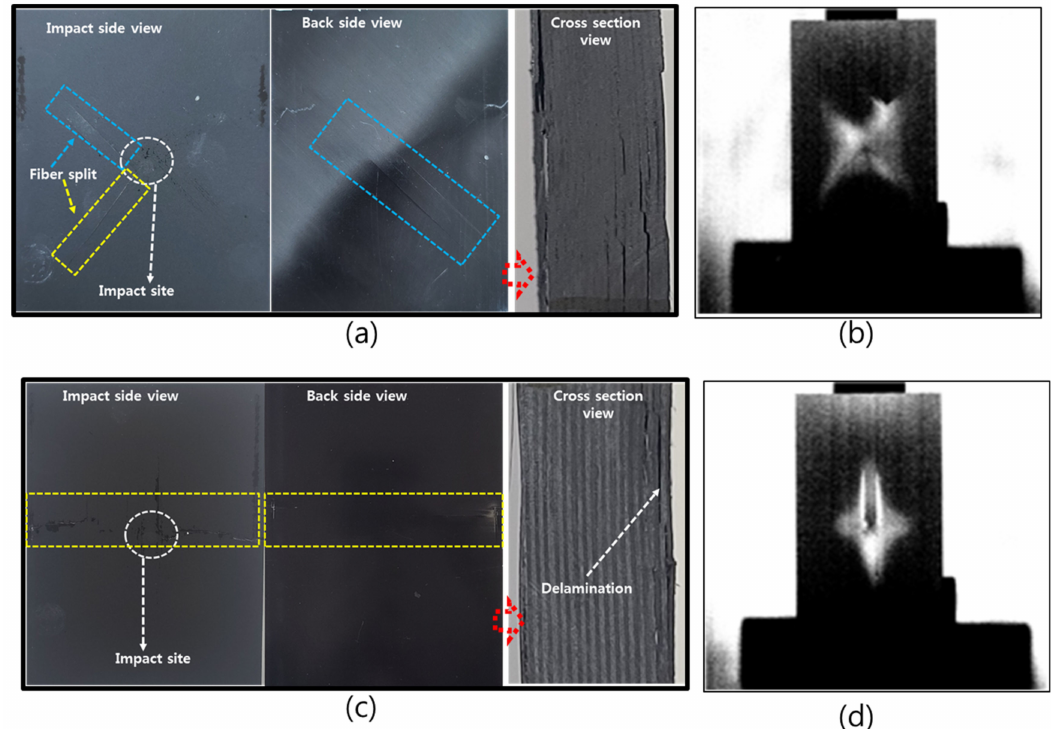
Figure 6. Digital camera images for external view (left) and lock-in thermography image for defects detections (right): ( a , b ) Specimen lamination in +45 ◦ / − 45 ◦ and ( c , d ) Specimen lamination in 0 ◦ /90 ◦